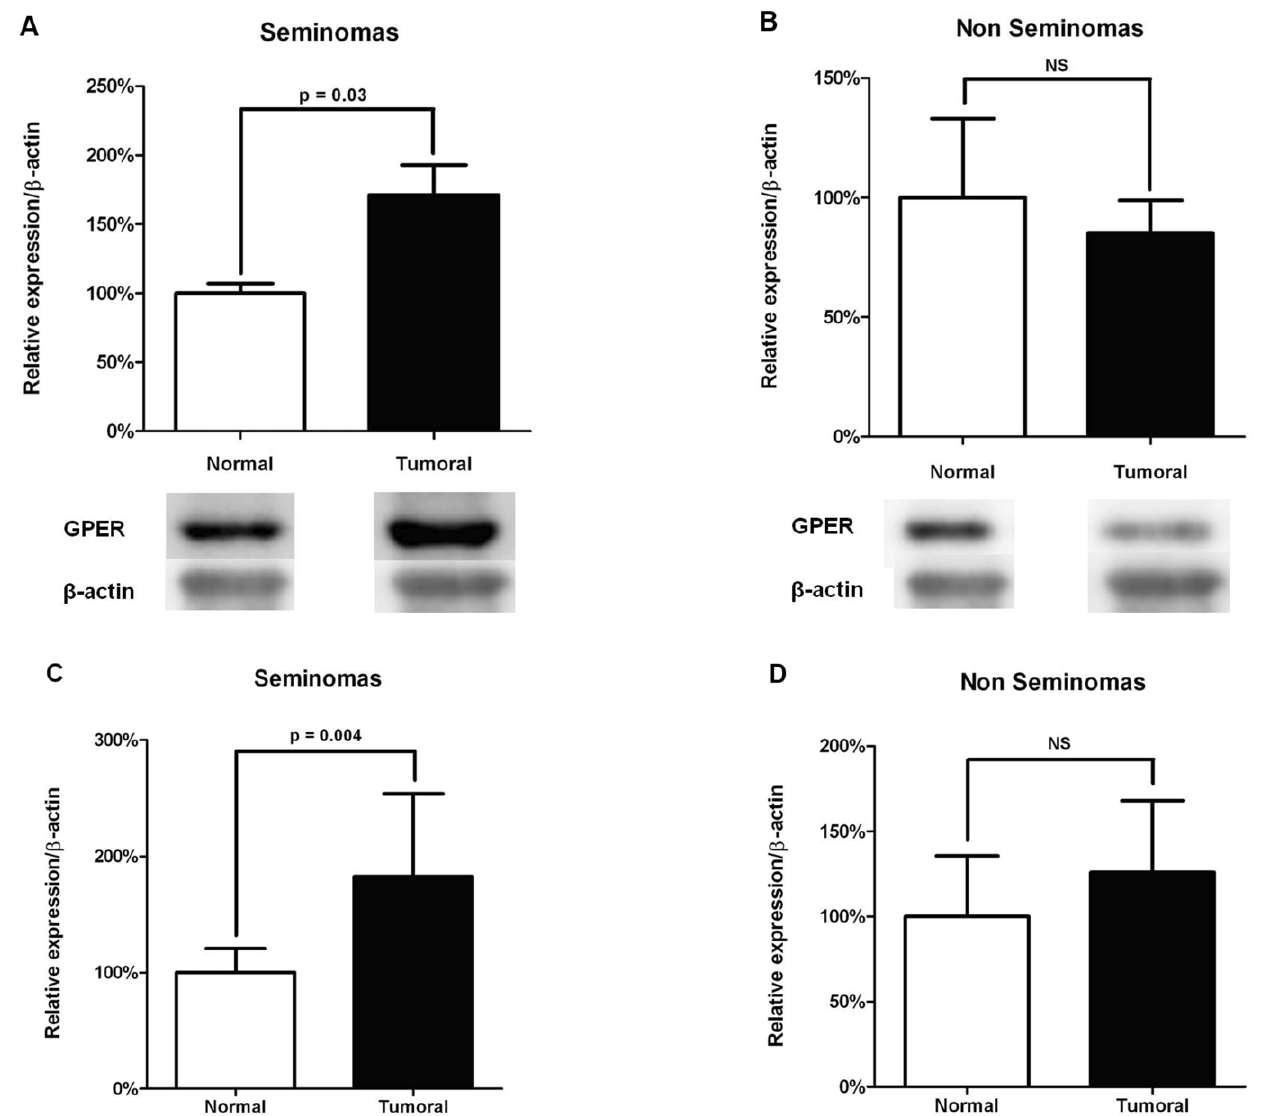
Figure 3. GPER expression in seminoma and non seminoma tumours. Quantitative analysis of GPER expression was performed by Western blotting (A, B) and RT-PCR (C, D) in testicular germ cell tumours. b -actin was taken in each case as a house-keeping gene both in Western blotting and RT-PCR. Relative expression of GPER mRNA and protein of the tumoural tissue was expressed as percentage of the value obtained in the normal peri- tumoural testicular tissue of the same testis (represented as 100%). Histograms show the mean and standard deviation of the mRNA and protein values for a group of 8 seminomas (A, C) and for a group of 7 non seminomas (B, D). Both mRNAs and protein values were significantly higher in seminomas when compared to normal peri-tumoural testicular tissue (A, C). At the opposite, mRNAs and protein values were not different (P . 0.05) in non seminoma tumours when compared to normal peri-tumoural testicular tissue (B, D).